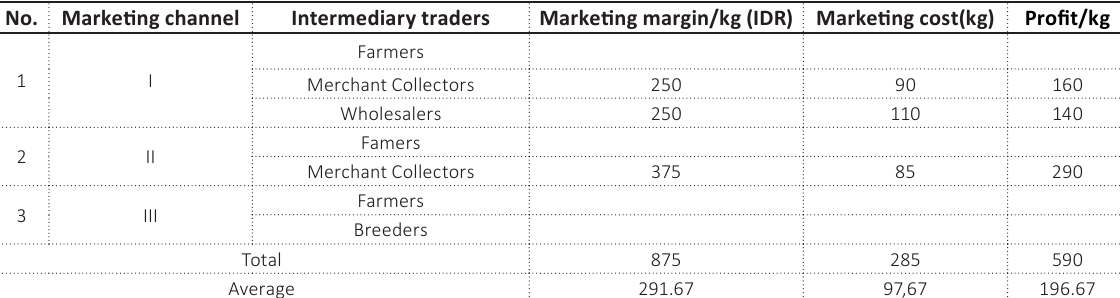
Source: Primary data processed,